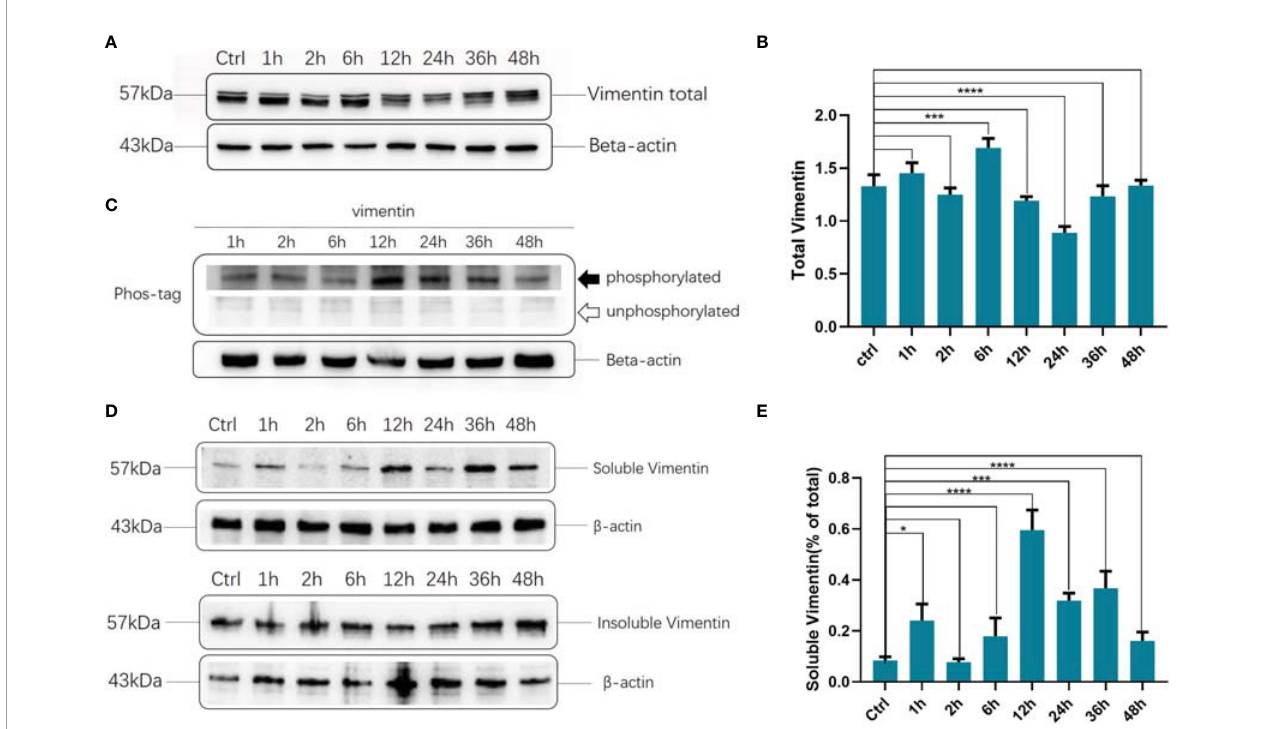
FIGURE 2 | Dynamic changes in total protein, phosphorylation, and solubility of vimentin after dengue virus (DENV)-2 infection. (A) Changes in vimentin expression after DENV-2 infection of human brain microvascular endothelial cells (HBMEC) at different time points. (B) Grayscale analysis of the results of Figure (A, C) Changes in vimentin phosphorylation after DENV-2 infection in HBMECs were detected. (D) Soluble and insoluble fraction of vimentin at different time points of DENV-2 infection in HBMECs, as detected by western blotting. E Grayscale analysis of Figure (D) . (A-E) Ctrl: control group. (B, E) *P < 0.05; ***P < 0.001; ****P <